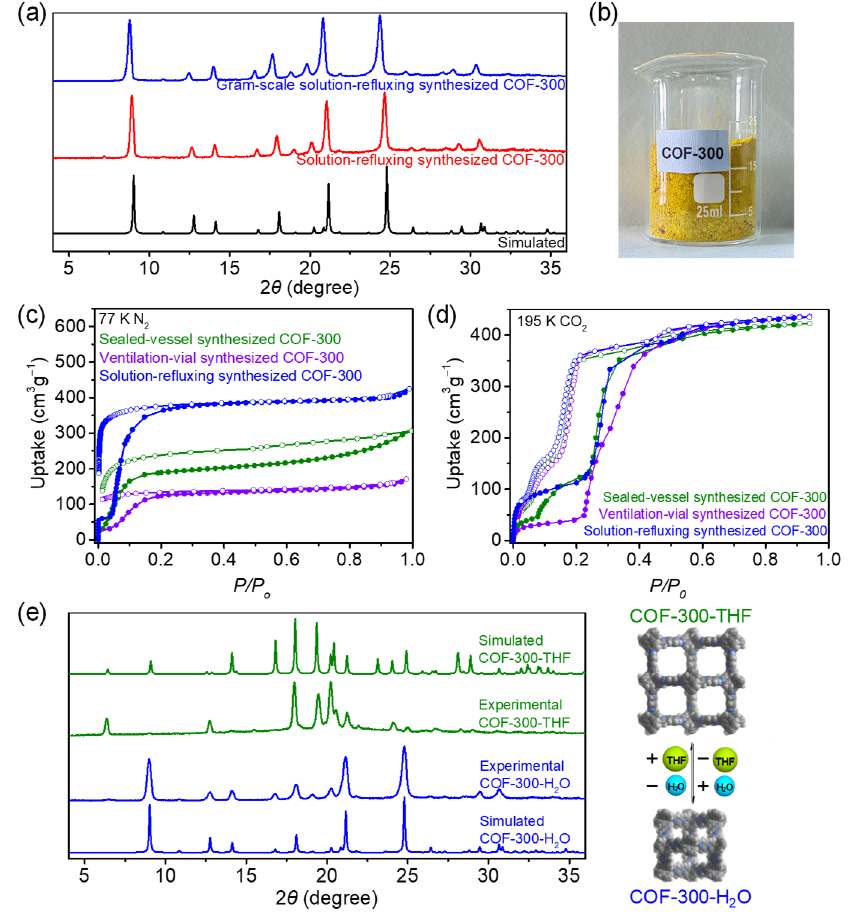
Figure 3. ( a ) PXRD patterns and ( b ) appearance of gram-scale solution-refluxing synthesized COF- 300; ( c ) Nitrogen sorption isotherms at 77 K and ( d ) carbon dioxide sorption isotherms at 195 K; ( e ) The solvent-dependent PXRD patterns of COF-300.